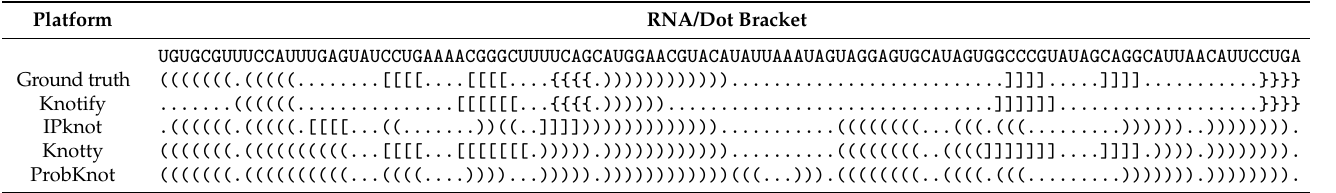
Table 3. L-type pseudoknot